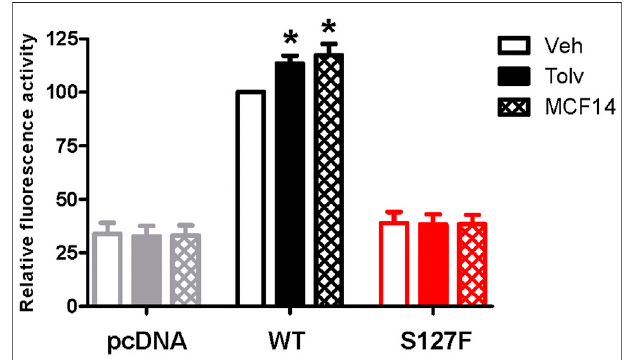
FIGURE 6 | Measurement of the effect of pharmacochaperone treatmenton cellsurface expression ofWT-V2RorS127F-V2R.HEK293cells were transiently transfected with either HA-tagged V2-receptor construct or pcDNA3.1 and after 24 h of transfection, the transfected cells were treated with 100 nM tolvaptan or 10 µM MCF14 or vehicle (DMSO) for 18 h. Cell surface expression values of the immuno fl uorescent labeled receptors were analyzed and quanti fi ed by fl ow cytometry. Non-speci fi c fl uorescence was determined by measuring empty pcDNA3.1 transfected HEK293 cells incubated with anti-HA-Alexa 488 antibodies. The cell surface expression values are expressed as a percentage of the vehicle-treated V2R median fl uorescence values done in the same experiment, each performed in triplicate. Mean values ±S.E. are shown ( n = 3). Signi fi cance was calculated with one-way ANOVA test (* p <